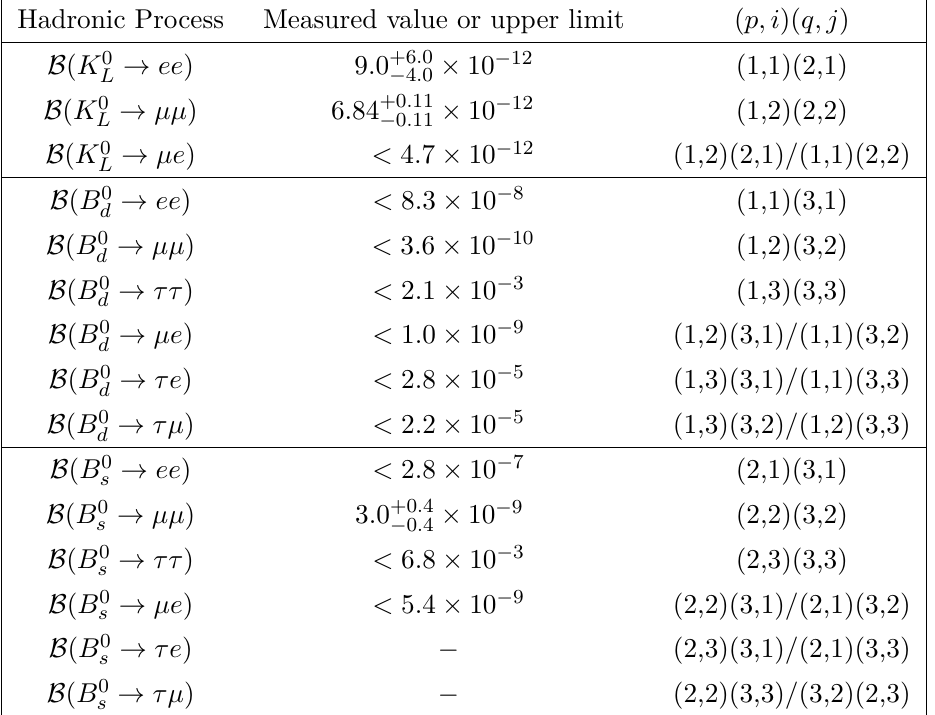
Table 2 . Experimental measurements and upper limits on rare leptonic decays of various pseudo- scalar mesons which form the dominant constraint on the scale of Pati-Salam breaking. The third column represents which entries of the matrices ( K de the given decay channel to occur via X ( d, s, b ) = (1 , 2 , 3) and i, j to the final state charged leptons ( e, µ, τ ) = (1 , 2 , 3) for the diagram in figure 2. Lepton-flavour violating decay modes can occur via two different possible